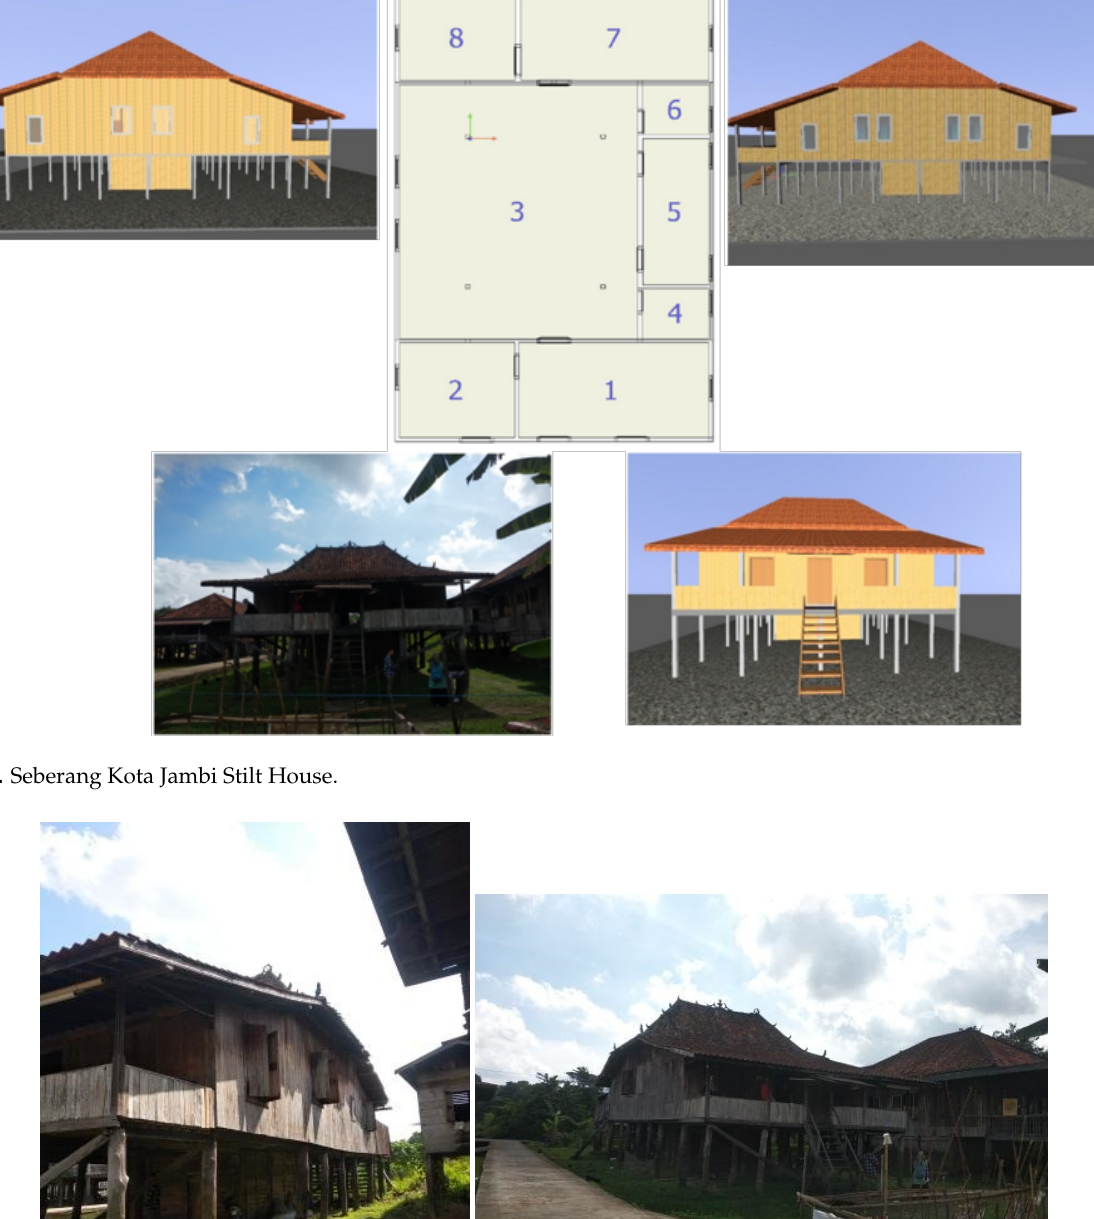
Fig. 4. Obstruction of the environment around the stilt